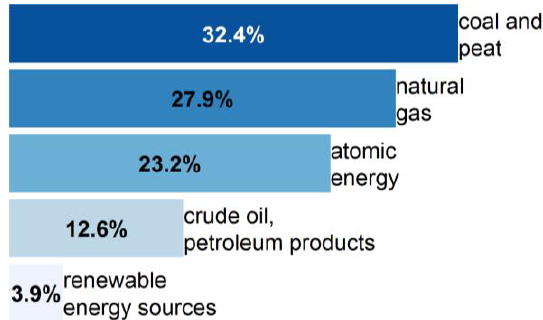
Figure 5. The structure of energy consumption of Ukrainian economy in 2016. Source: [88].